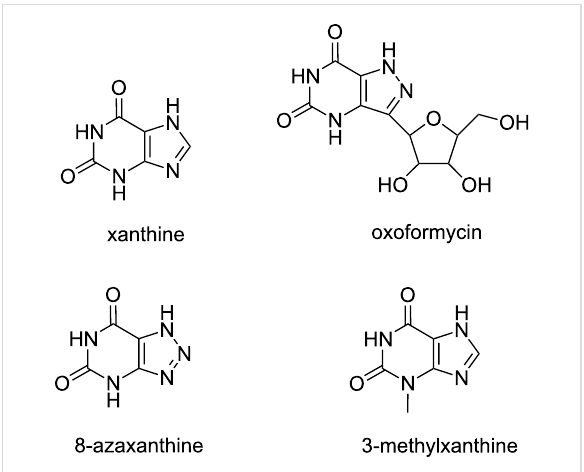
Figure 8: Structural representation of ethidium and safranin T cations.